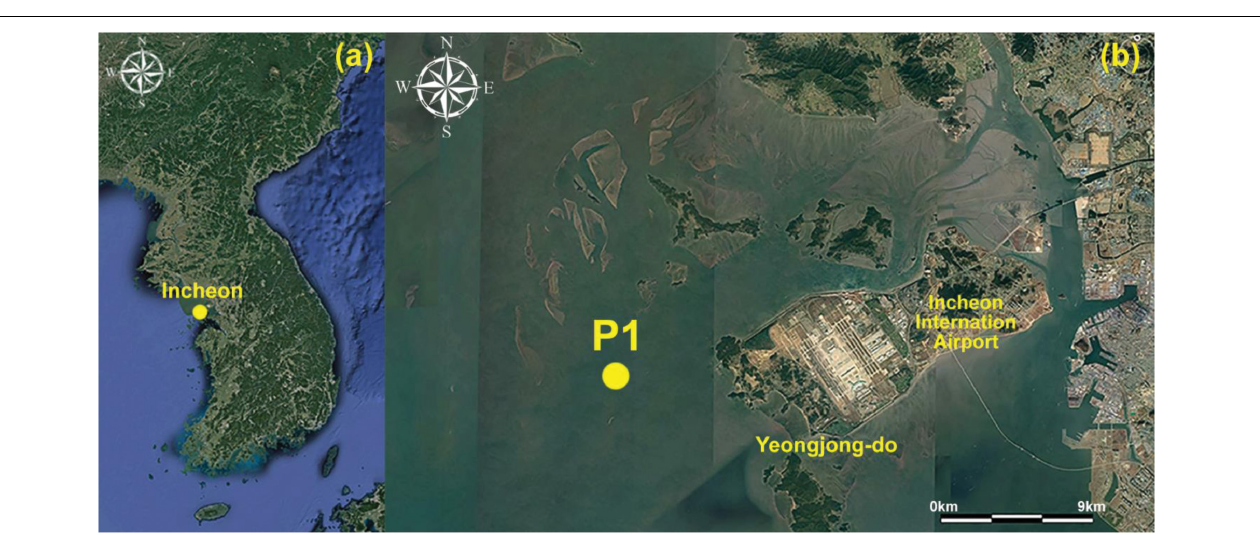
Note that the water temperature is higher and lower during low and high tides, respectively ( Figure 12d ). The water temperature increased during the high tide in the shallower area in which mud flats developed ( Figure 8 ) and flowed out to the deeper area (close to location P1) with the ebb tide. During the flood phase, the water temperature of the top layer was 1.0–1.5 ◦ C higher than that of the bottom layer. When the heavier cold